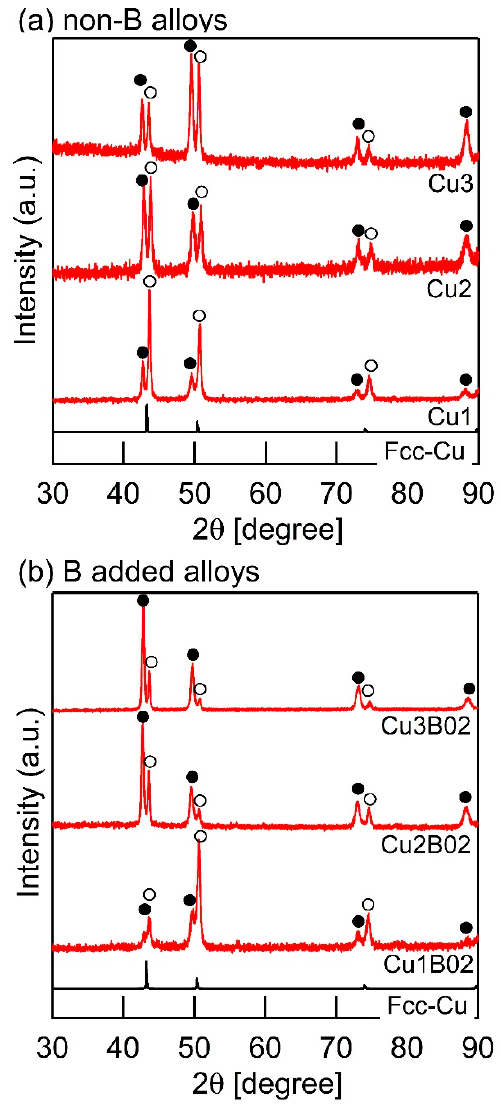
Figure 6. XRD pattern of the arc-melted ingots of the non-B CoCrCu x FeMnNi (x = 1, 2, 3) (Cu1, Cu2 Cu3) HEAs and B-added CoCrCu x FeMnNiB 0.2 (x = 1, 2, 3) (Cu1B02, Cu2B02 Cu3B02) HEAs. ( a ) Non-B CoCrCu x FeMnNi (x = 1, 2, 3) (Cu1, Cu2 Cu3) HEAs, ( b ) B-added CoCrCu x FeMnNiB 0.2 (x = 1, 2, 3) (Cu1B02, Cu2B02 Cu3B02) HEAs.